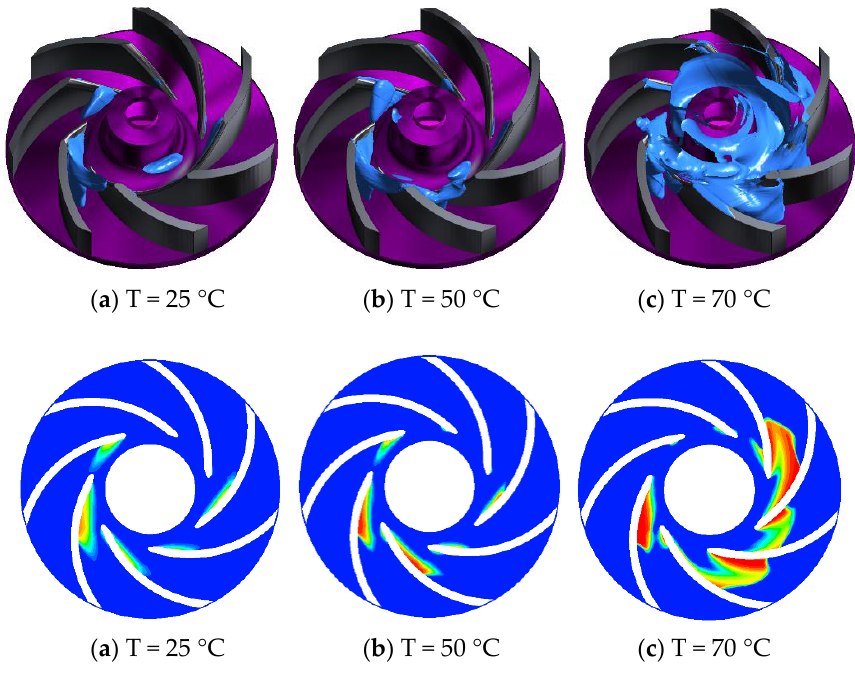
Figure 14. Vapor distribution with different temperatures based on the same cavitation.